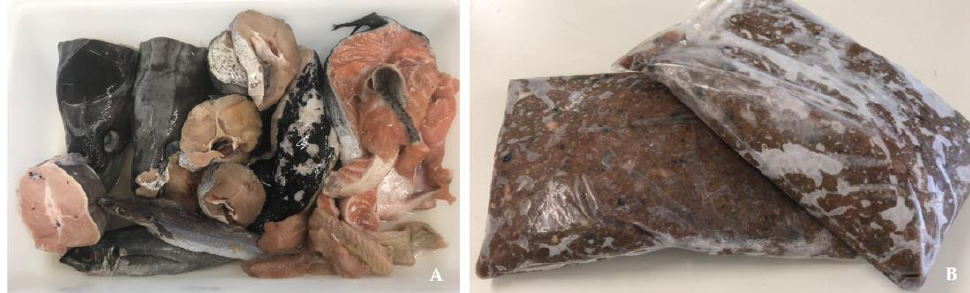
Figure 1. Industry-supplied fish by-product samples: unprocessed refrigerated sample, S1 ( A ); and frozen standard ground sample, S2 ( B ).